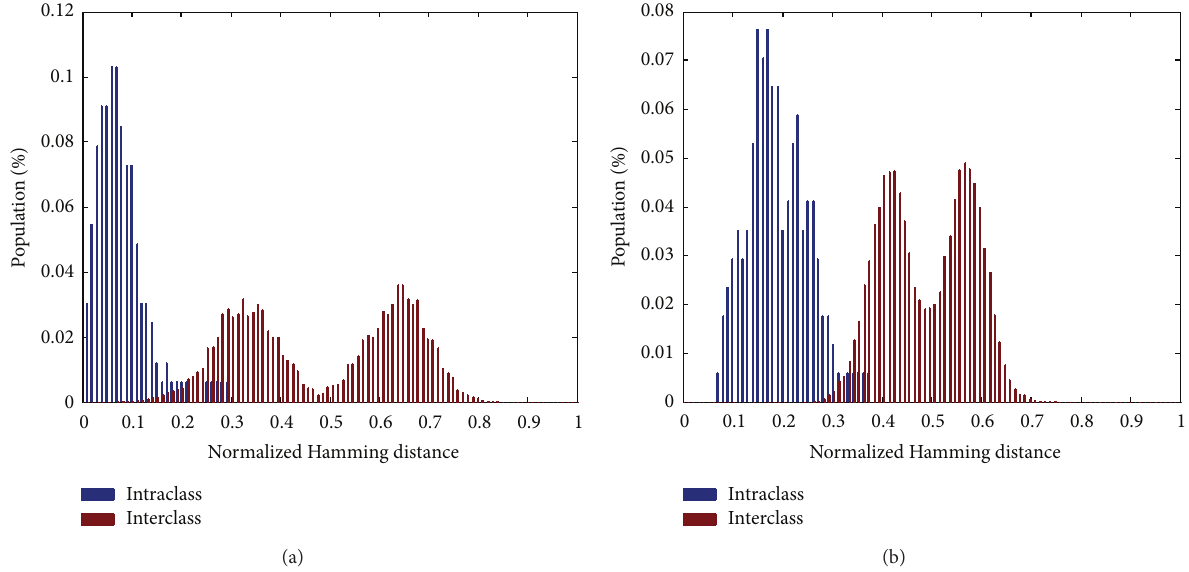
Figure 5: The Hamming distance of intra- and interclass binary vectors of lengths of 127 (a) and 255 (b).